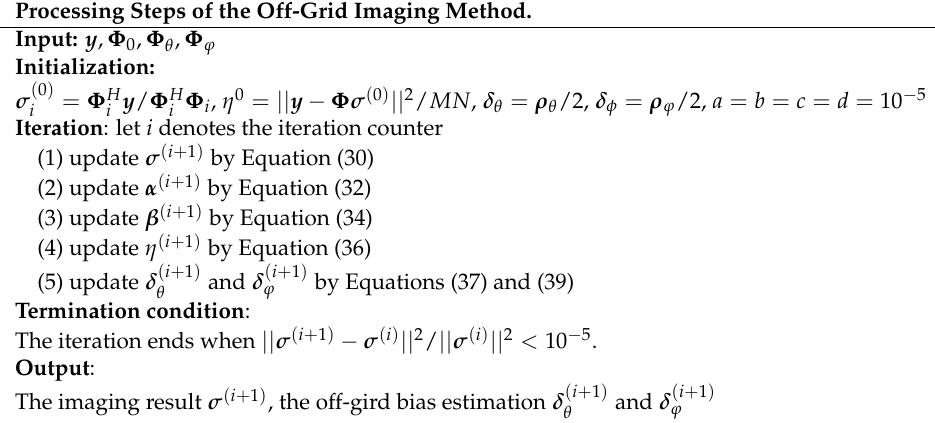
Table 1. Main steps of the proposed imaging